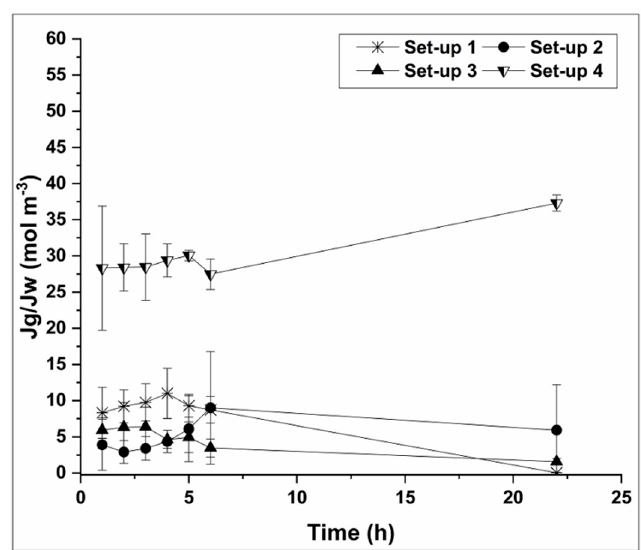
Figure 7. Specific reverse glycerol flux during different FO operation setups. The specific reverse glycerol flux for set-ups 1, 2, and 3 (high Total-ATP accumulation on the membrane coupons) was considerably lower than set-up 4 (very low Total-ATP accumulation on the membrane coupons). Specific reverse flux for set-up 5 was inconsistent between the replicates.